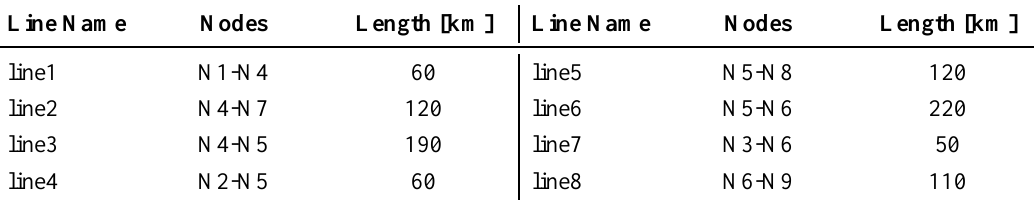
Table 1. MTDC network lines.